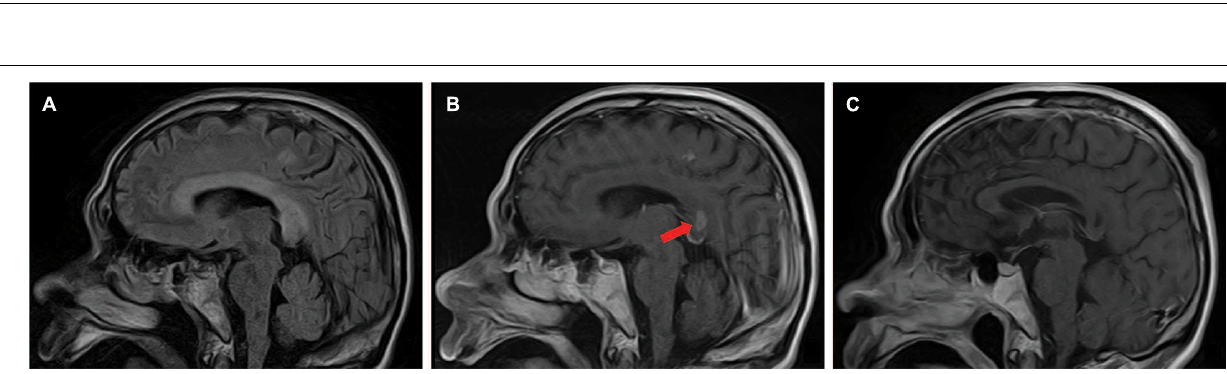
FIGURE 1 | Axial images of brain MRI performed 7 days (A–C) and 22 days (D) after onset. MRI performed 7 days after onset revealed symmetrical and bilateral hyperintense lesions on diffusion-weighted imaging (DWI) (A) , and T2-weighted imaging (B) throughout the entire corpus callosum (CC). Extracallosal lesions could also be seen (A,B) . T2-weighted imaging had a considerable amount of distortion due to motion because the patient couldn’t cooperate well (B) . Gadolinium enhancement could be seen in part of splenium (C, arrow) . 22 days after onset, follow-up MRI showed only mild remaining of the formerly impressively hyperintensity on D2-weighted imaging, and the formation of necrosis in the splenium (D) .